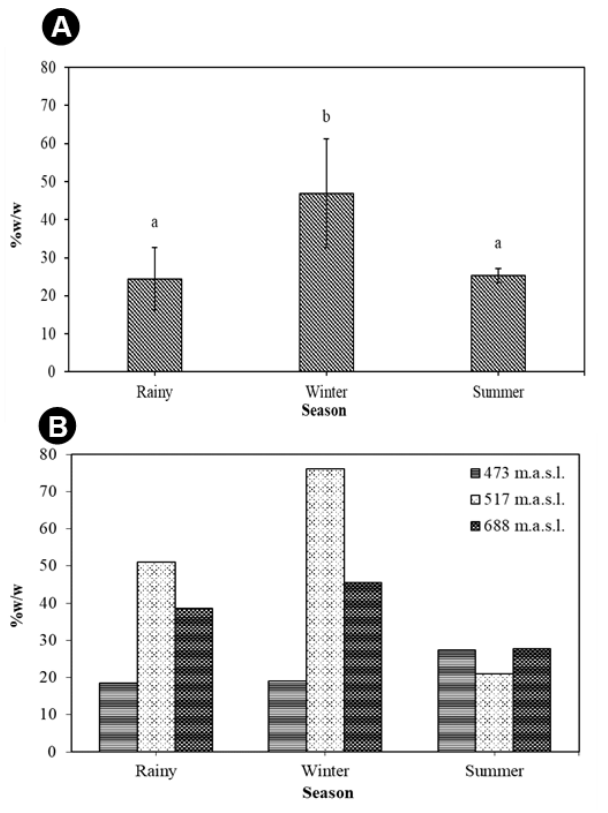
Figure 14 ( A ) β -Carotene (%w/w) content by season. The data are the mean values of three replications, and the SE is indicated by vertical bars and the different letters above the columns indicate significant differences ( p ≤ 0.05, n = 3) at each time by Duncan’s new multiple range test. ( B ) β -Carotene (%w/w) content by each sampling point in each season of T. rigidula collected from electricity